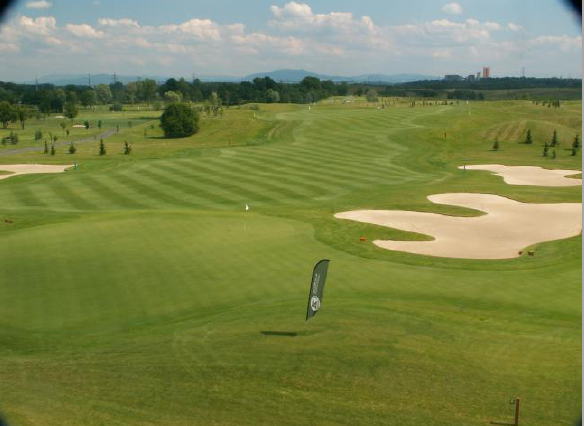
Fig. 6. Modified channel of the Olše River – a lake in the Karviná Park ( J. Havrlant ,